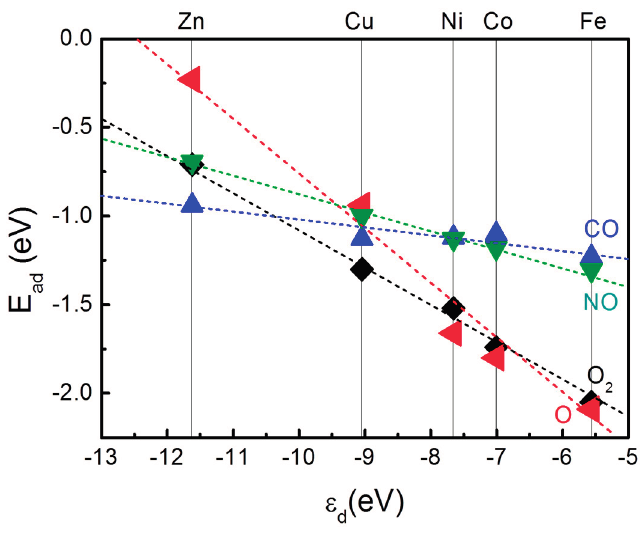
Figure 5. The calculated adsorption energy, E ad , plotted vs. calculated weight-average of TM-d states with respect to vacuum, ε d . The calculated E ad correlates well with ε d . The dashed lines are to guide the